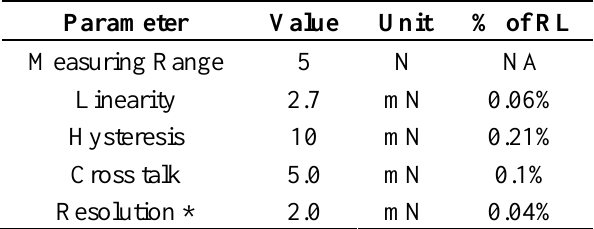
Table 2. Main performance parameters for the developed sensor